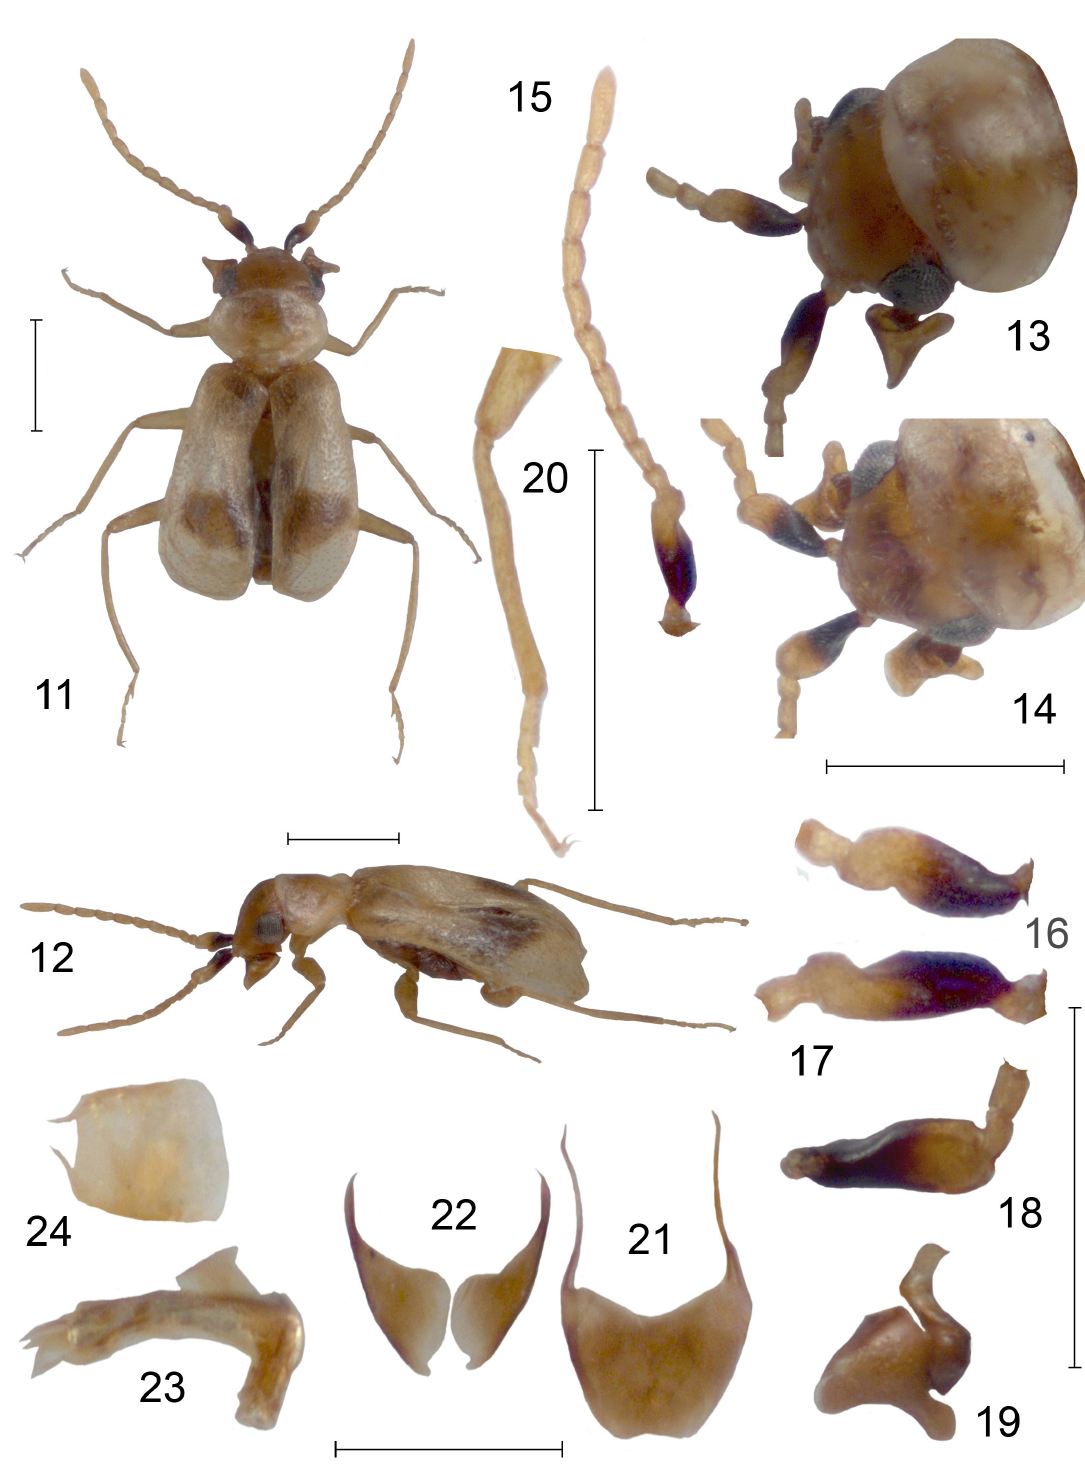
Figs 11–24. Tonycolotes kovari (Švihla, 1987) gen. et. comb. nov., ♂ (SCH_ISEA). 11 . External appearance, dorsal view. 12 . External appearance, lateral view. 13 . Head and pronotum, subdorsal view. 14 . Head and pronotum, dorsal view. 15 . Right antenna. 16–18 . Scapus in different positions. 19 . Left palp. 20 . Left anterior leg. 21 . Pygidium. 22 . Ultimate abdominal ventrite. 23 . Aedeagus, lateral view. 24 . Tegmen. Scale bars: 0.5